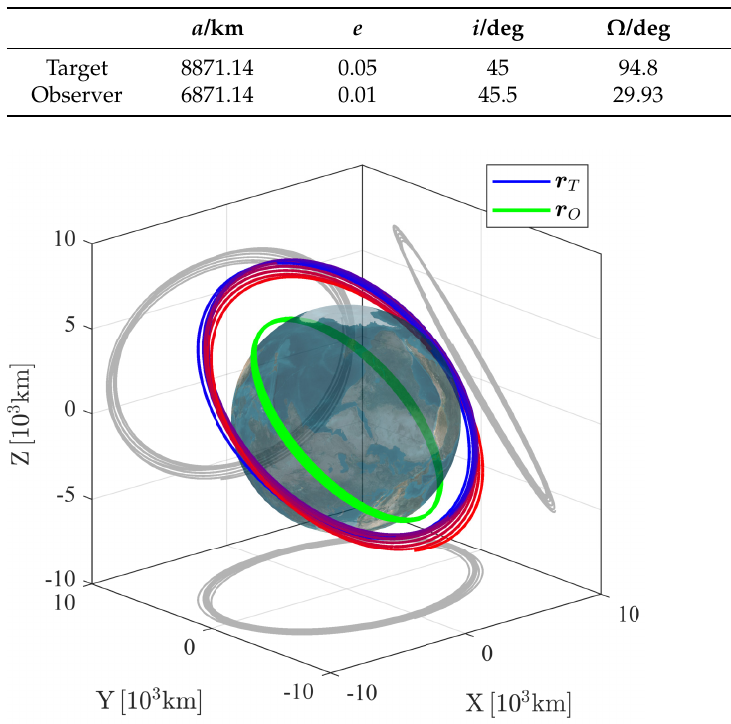
Table 1. Nominal orbit elements of the target and the observer.